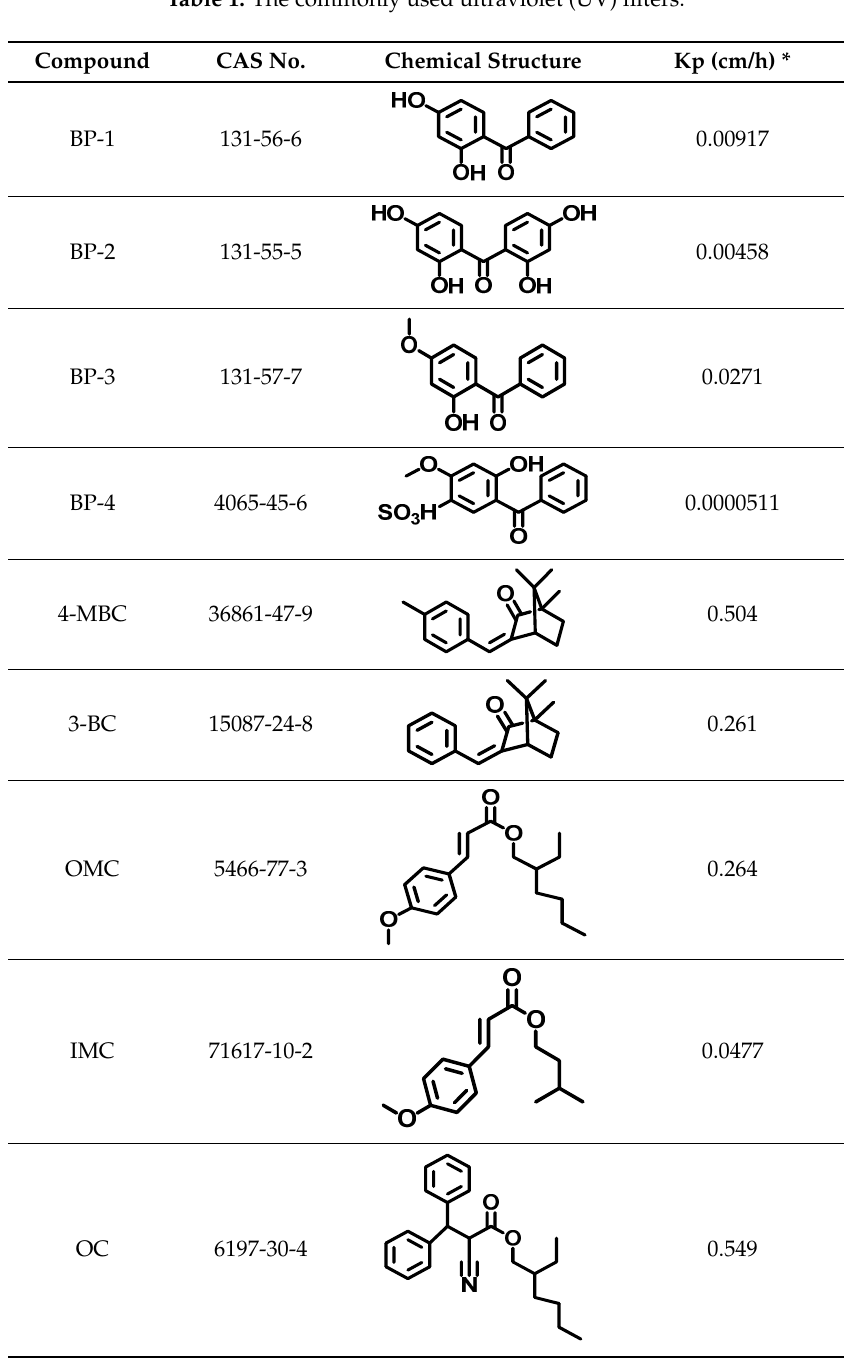
Table 2. Endocrine disrupting effects of the commonly used UV filters UV Filters